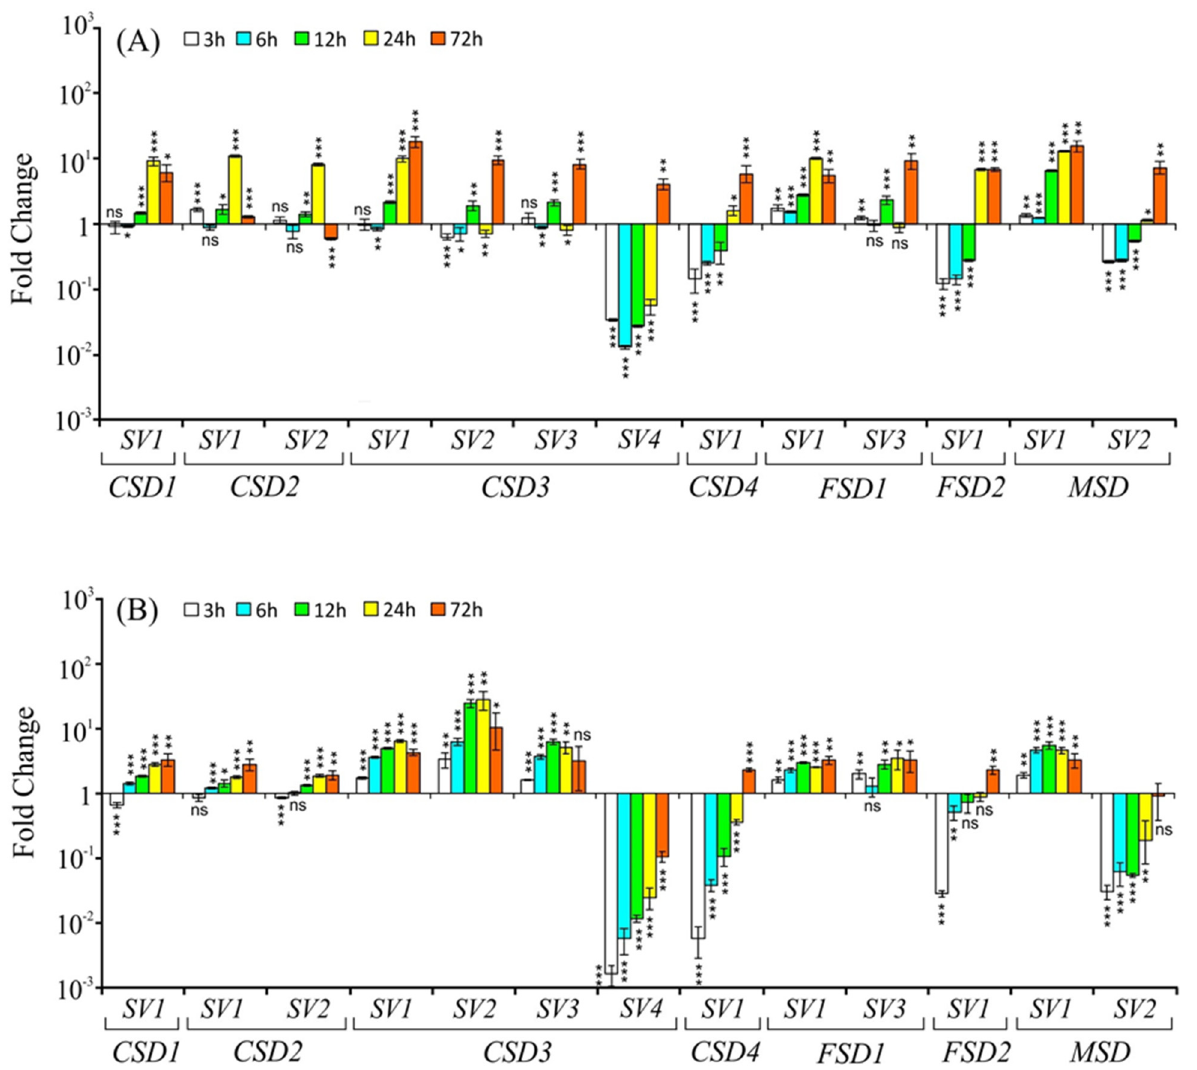
Figure 6. Relative transcript levels (on Y -axis) of CSDs , FSDs , and MSD splice variants (indicated by numbers on X -axis) in response to 100 μ M Cu 2+ stress, in shoot ( A ) and root ( B ) tissue at 3 h, 6 h, 12 h, 24 h, and 72 h after the stress treatment. For normalization and statistical analysis, see figure legend 3.